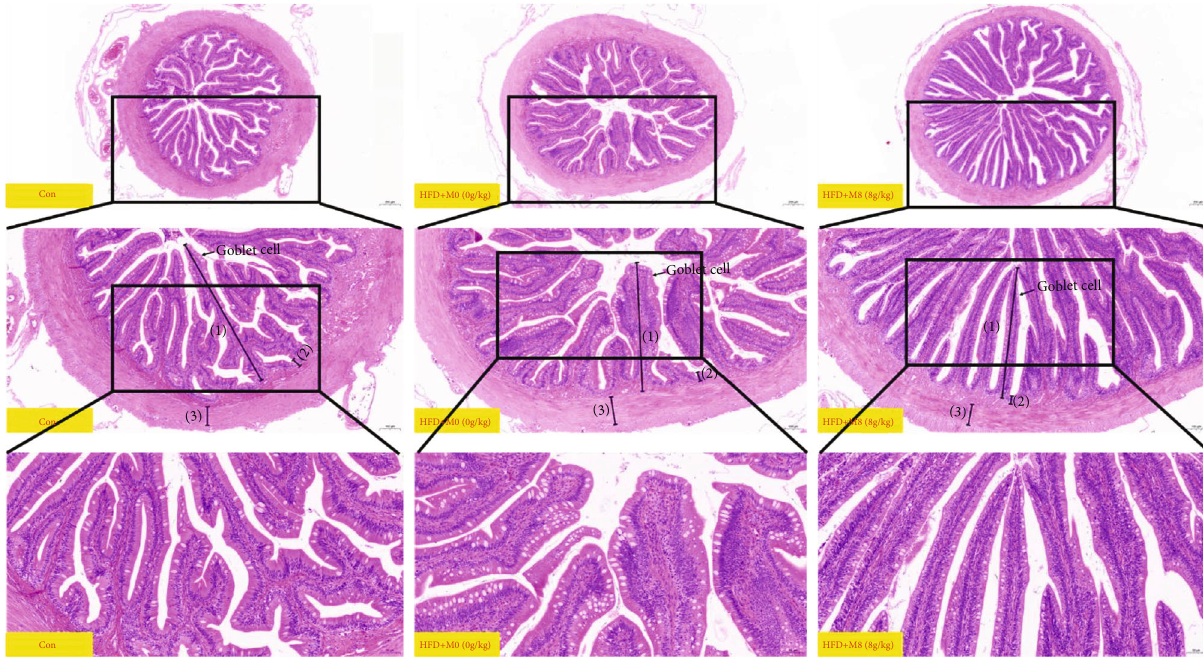
Figure 2: E ff ects of high-fat diet supplemented methionine on the intestinal H&E stained sections: (1), (2), (3), and (4) were shown intestinal villus height, crypt depth, intestinal muscular thickness, and intestinal goblet cell, Table 7: E ff ects of high-fat diet supplemented methionine on the intestinal H&E-stained sections (100 times and 400 times). Index